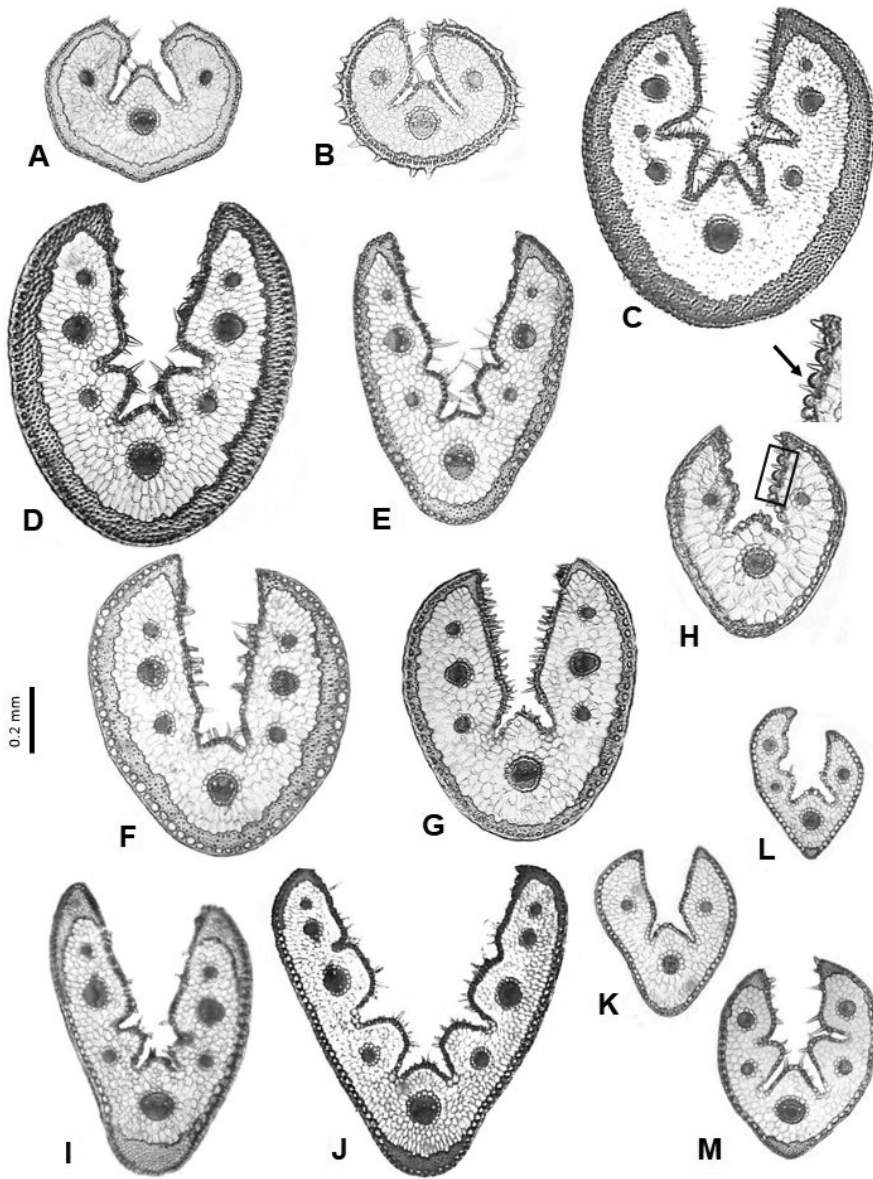
Figure 4. Leaf cross-sections of the Festuca sect. Festuca species from lineage 1. A F. hystrix B F. rever- chonii C F. segimonensis D F. indigesta E F. michaelis F F. glauca G F. vasconcensis H F. brigantina subsp. actiophyta (the arrow indicates inflated adaxial epidermal cells) I F. marginata subsp. andres-molinae J F. ri- vas-martinezii K F. frigida L F. alpina M F. glacialis . Scale bars: 0.2